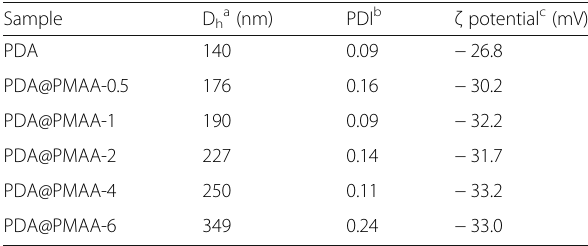
Table 2 The colloidal data of PDA and PDA@PMAA composite nanoparticles